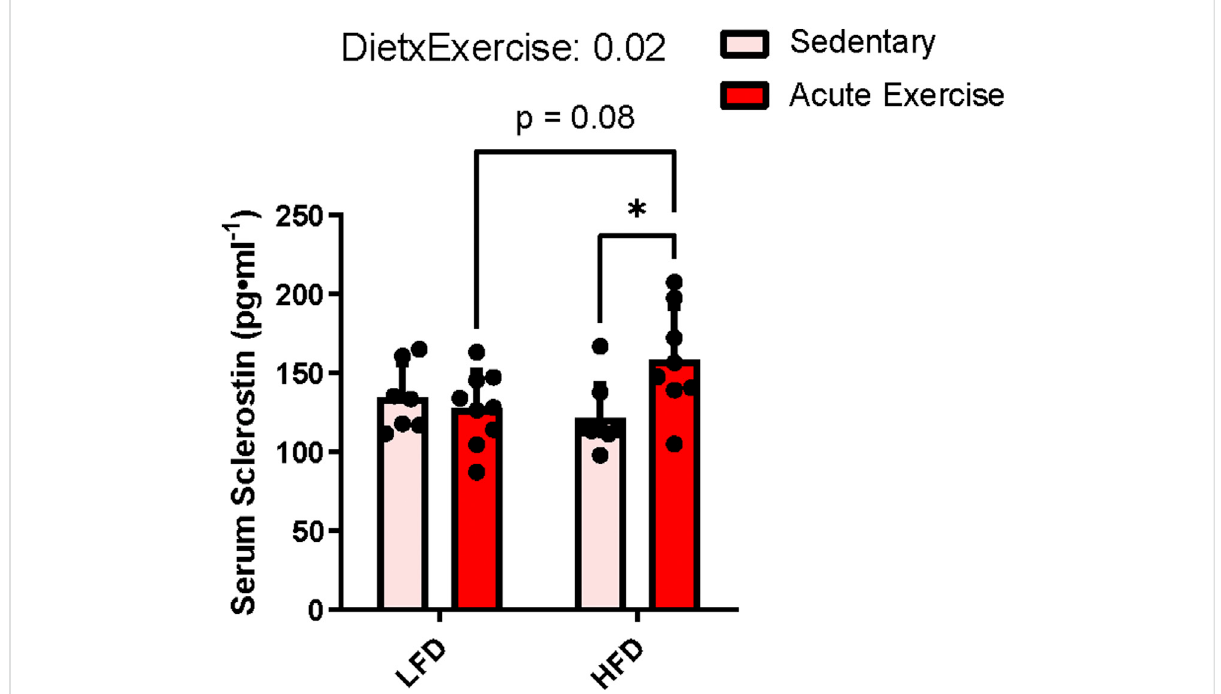
FIGURE 1 Serum sclerostin response to HFD and acute exercise. Light grey bars represent sedentary mice and dark grey bars represent mice sampled 2 h following2 hofacuteenduranceexerciseandaregrouped bydiet;LFD=lowfatdiet;HFD=highfatdiet.Dataarepresented asmeans±SD.Atwo- wayfactorialANOVAwasusedtoexaminemaineffectsfordietandexerciseaswelltheirinteraction. Tukey correctionwasusedformultiplepairwise